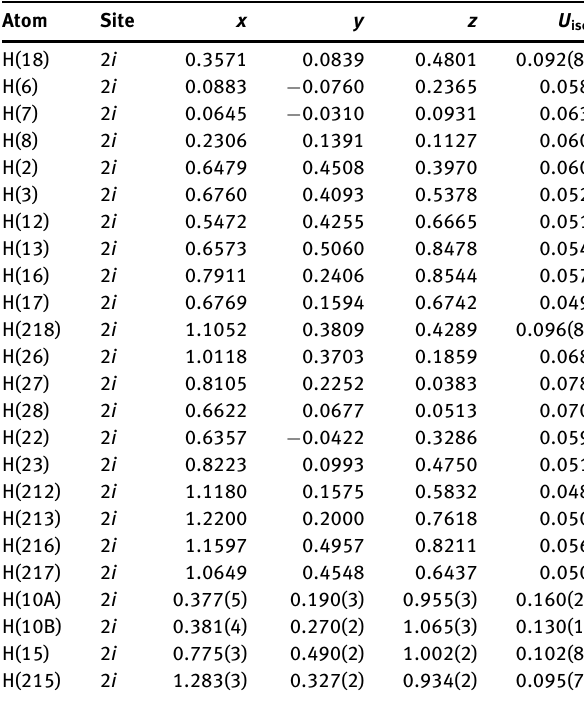
Table 2: Fractional atomic coordinates and isotropic or equivalent isotropic displacement parameters (Å 2